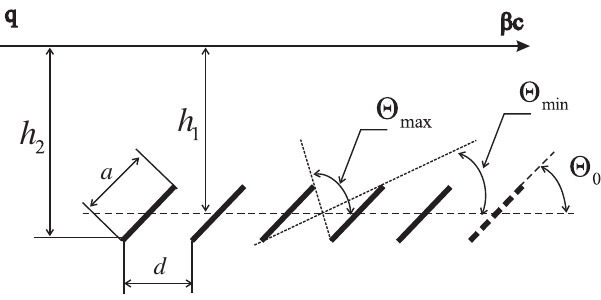
FIG. 2. Scheme of the Smith-Purcell radiation generation from the flat strip grating.